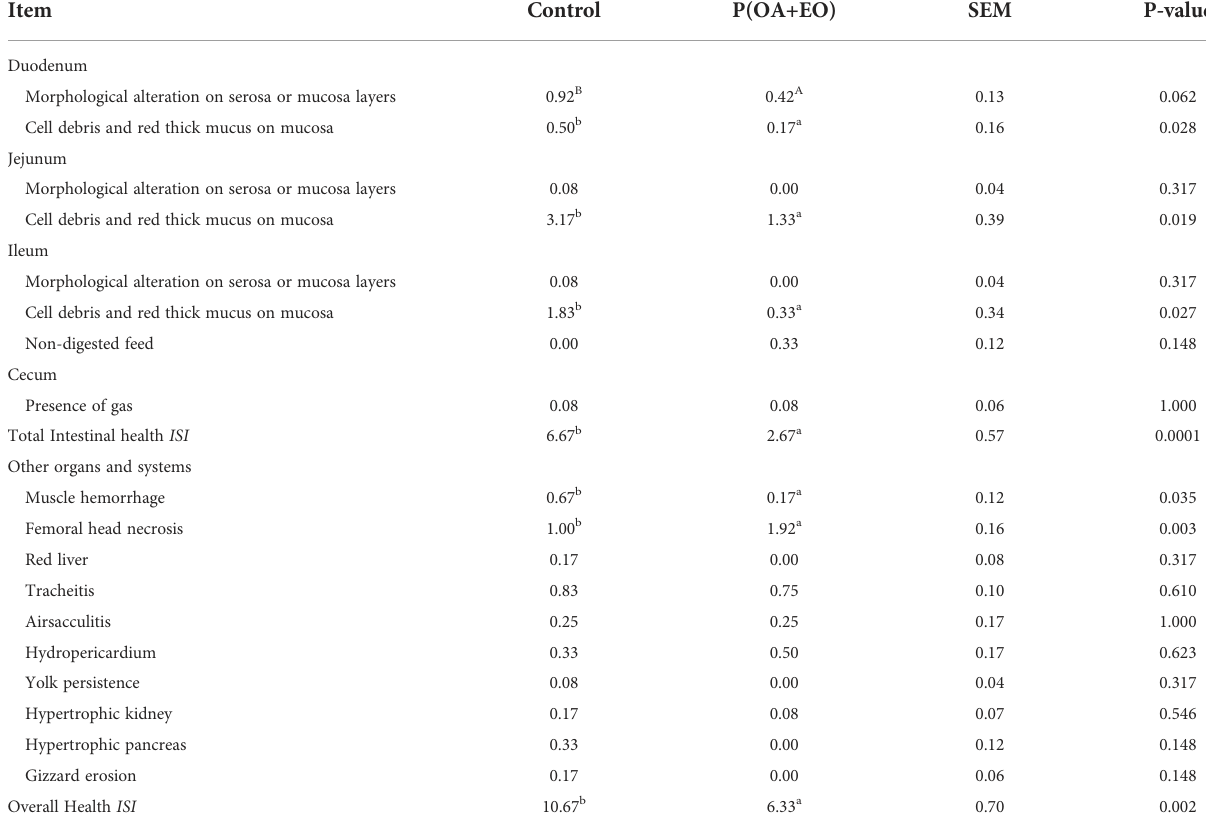
TABLE 1 Macroscopic intestinal and overall health – ISI score at 6 weeks of